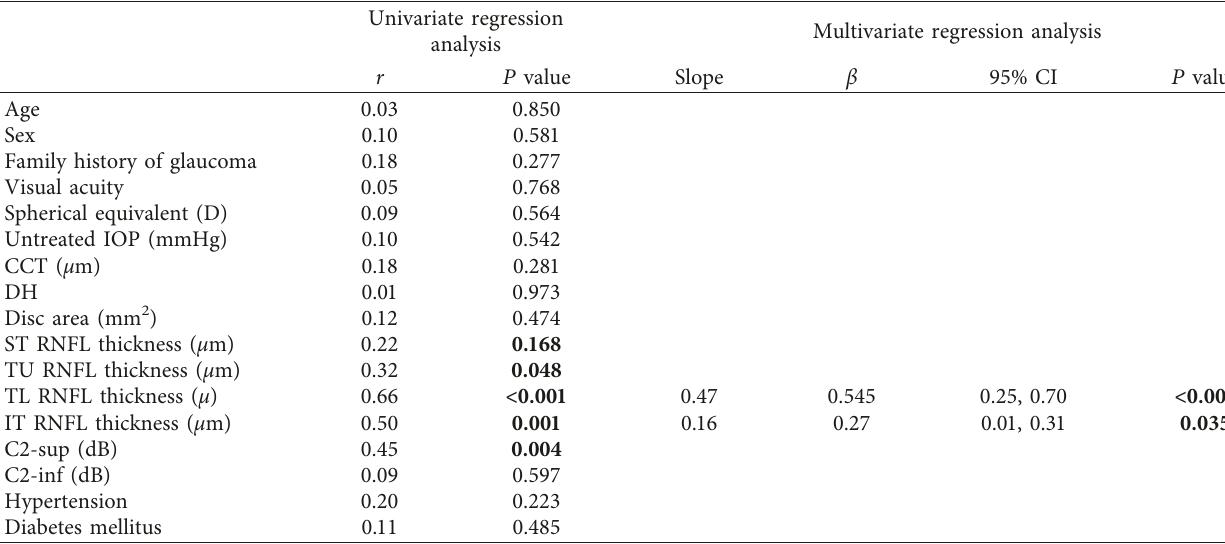
Table 3: Univariate and multivariate regression analyses for inferior mGCC thickness in the superior visual field defect